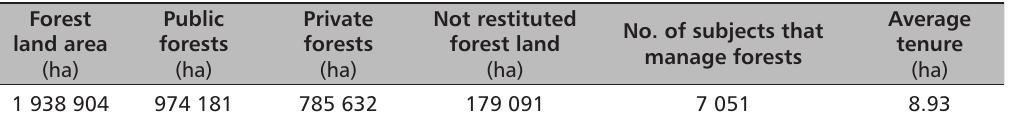
TABLE 1. Slovak forestry in 2010 (source